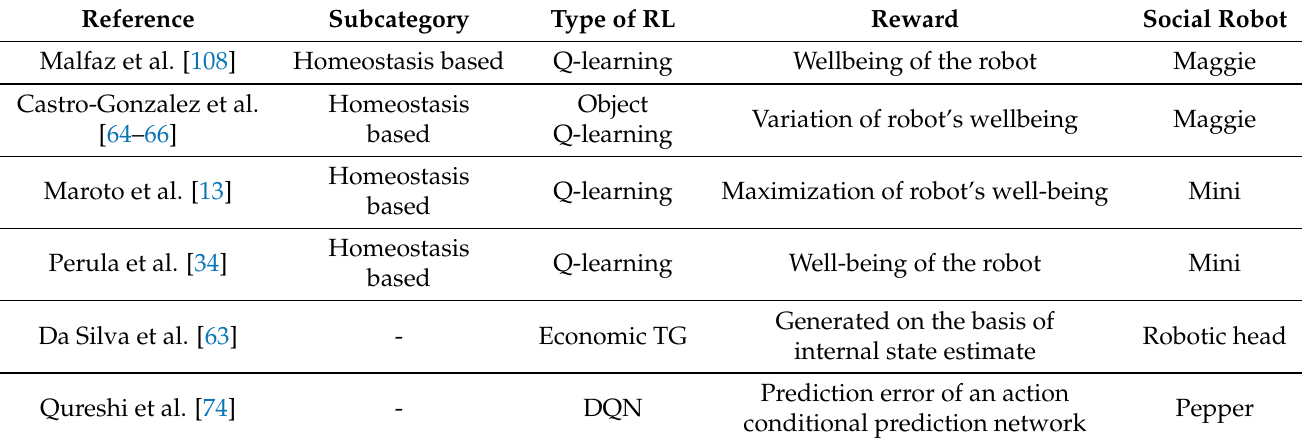
Table 2. Summary of Intrinsically Motivated Methods in social